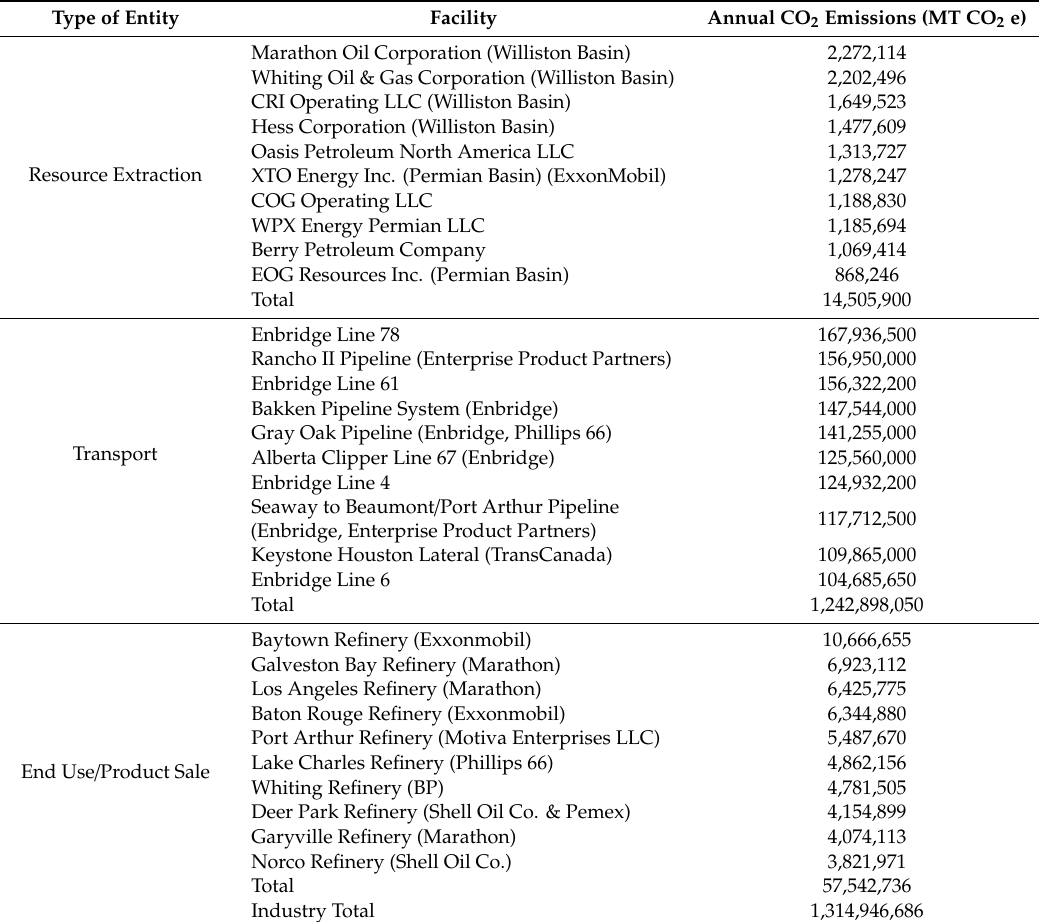
Table A2. Top CO 2 Emission Point-Sources of the Oil Industry for Resource Extraction, Transport, and End-use.